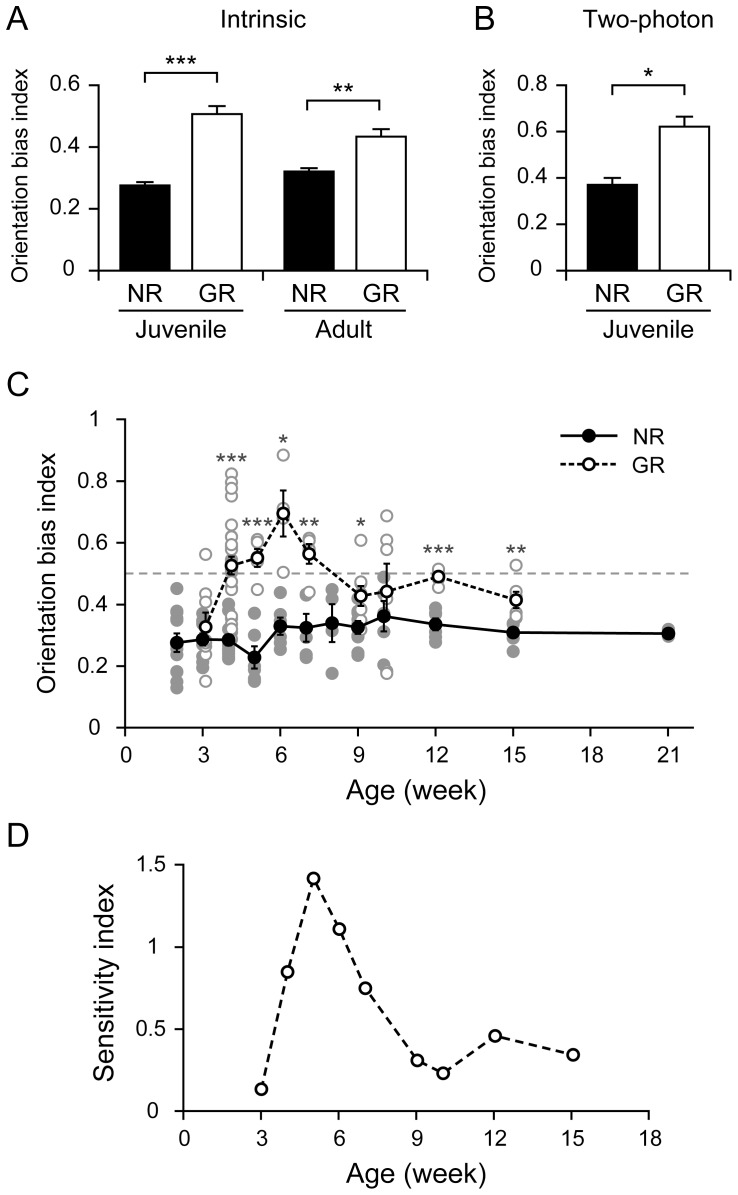
Orientation bias indices (OBIs) for NR and GR mice and sensitivity profile for orientation plasticity.(A) Averaged OBIs obtained from intrinsic signal imaging of NR and GR groups for juvenile and adult mice. (B) Averaged OBIs obtained from two-photon imaging of juvenile NR and GR groups. (C) Age dependence of OBIs averaged among animals of the same age for NR and GR mice. The dashed gray line indicates OBI = 0.5, corresponding to the absence of any representation bias towards the vertical or horizontal orientation. Faint dots indicate OBIs for individual mice. Error bars indicate SE. Significant differences in OBIs for GR and NR mice are shown as *p<0.05, **p<0.01 and ***p<0.001. (D) Sensitivity profile for orientation plasticity induced by the one-week of exposure to vertical orientation from 3w to 15w. The critical period for orientation plasticity is suggested to lie between 4w and 7w, during which the sensitivity index (SI) is prominently large. Also, orientation plasticity is found to be preserved to some extent even after 12w.